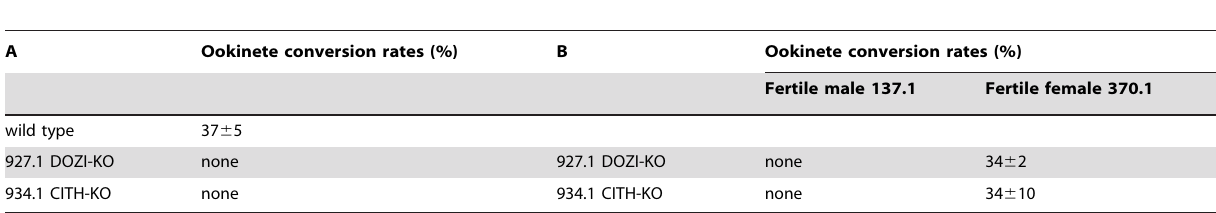
Table 1. Ookinete formation in wild type and mutant parasite lines.